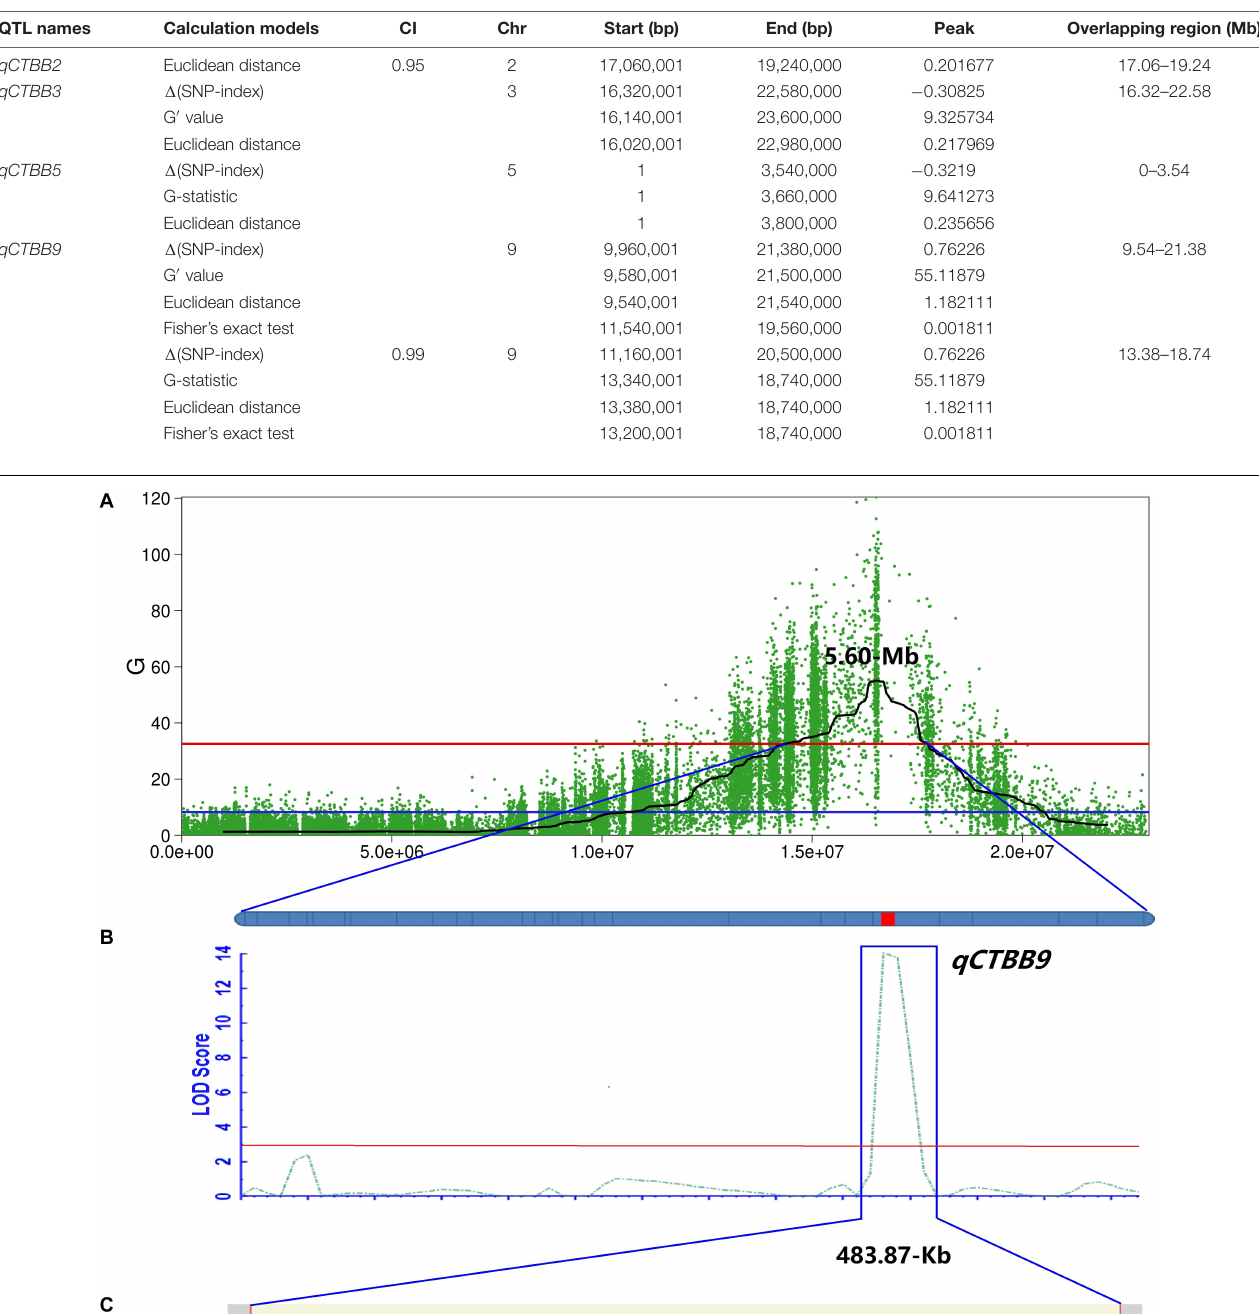
TABLE 1 | QTLs conferring cold tolerance in four method identified using QTL-seq.